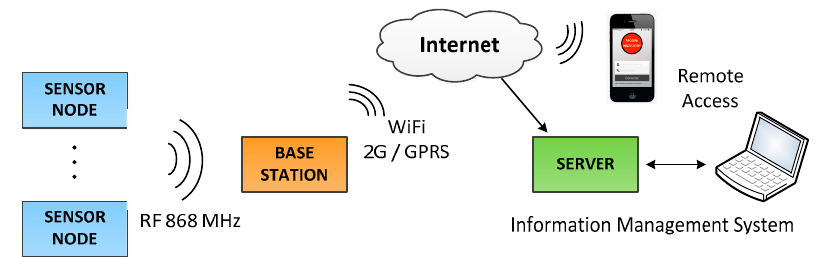
Figure 1. Architecture of the designed wireless sensor network.